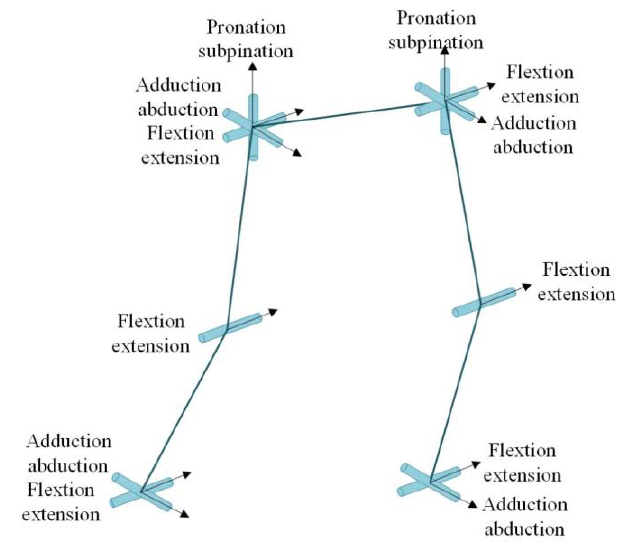
Figure 2. DOFs of the exoskeleton.